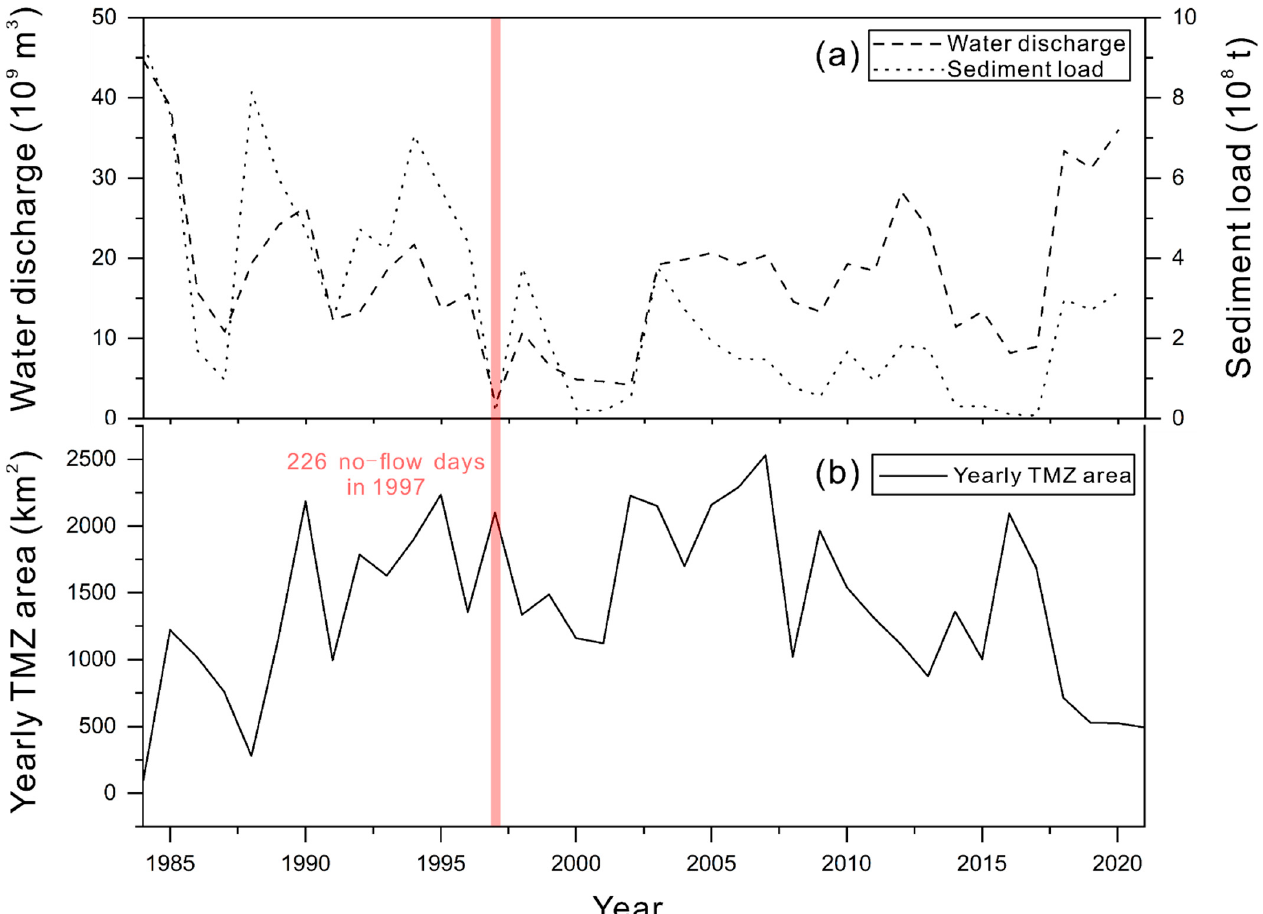
Figure 9. Water discharge and sediment load at Lijin gauging station ( a ) and yearly averaged TMZ area in the Yellow River estuary ( b ) from 1984 to 2021. The pink shaded area denotes the 226-day no flow event of the Yellow River in 1997.